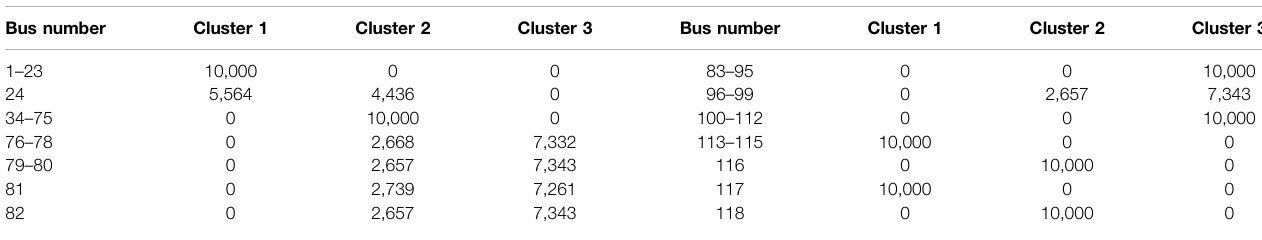
TABLE 4-1 | Simulation results at 20% penetration